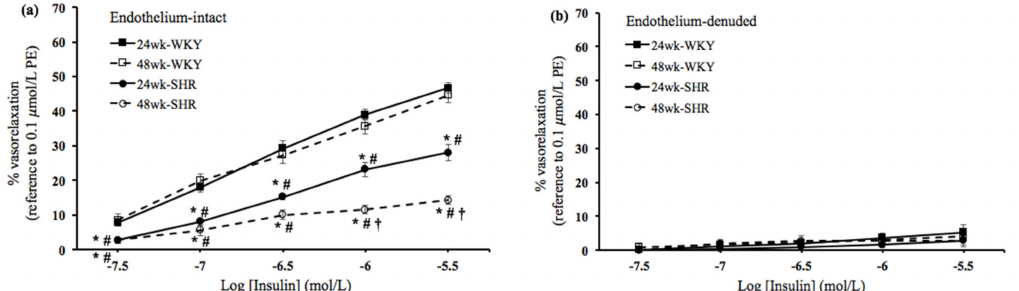
Figure 1. Insulin–mediated vasorelaxation. Insulin (3 × 10 − 8 to 3 × 10 − 6 mol/L)–mediated vasorelaxation at